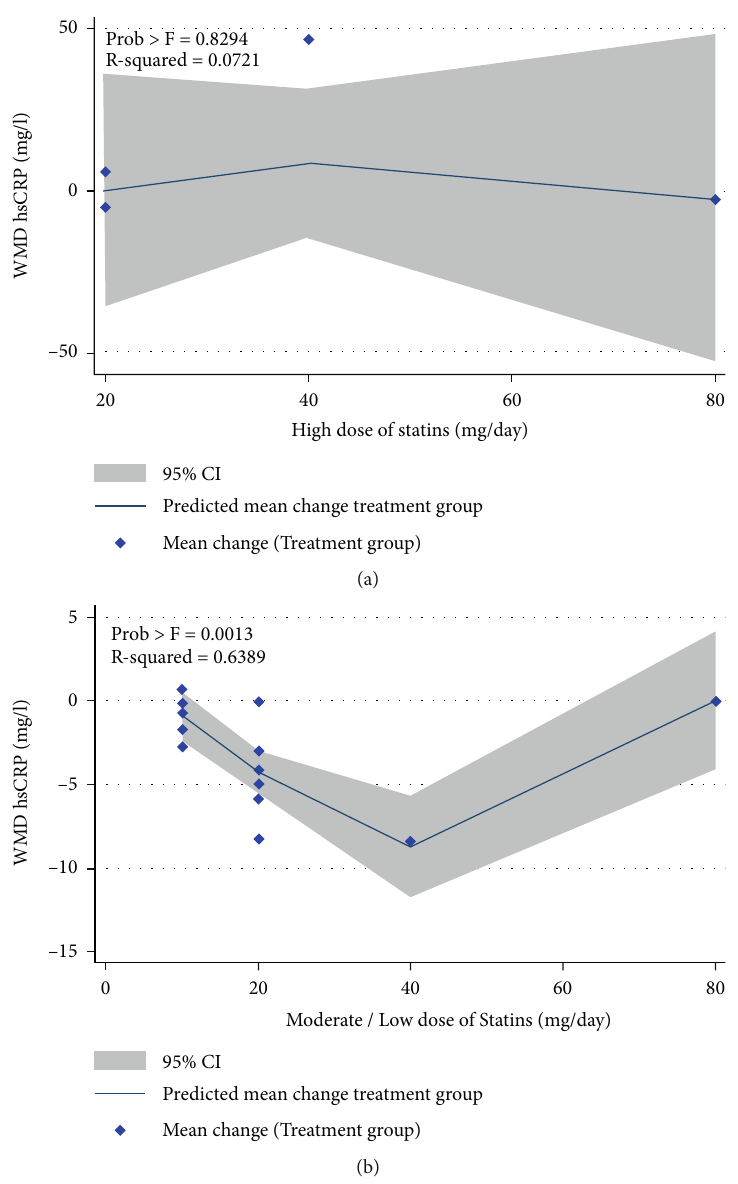
Figure 5: Nonlinear dose-response relations between dosage statin administration and WMD in hs-CRP: (a) high dose of statins and (b) moderate/low dose of